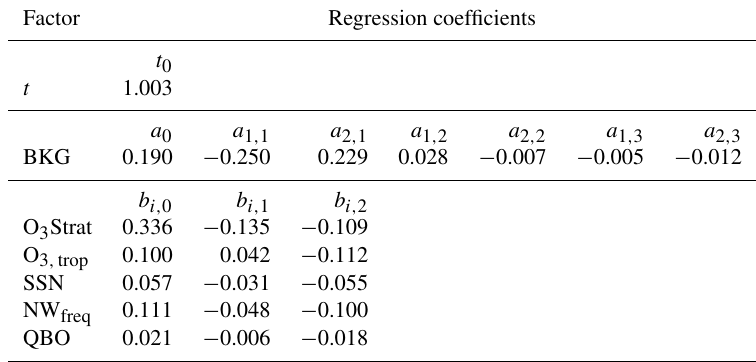
Table 6. Multivariate regression coefficients (Eqs. 6–7) of the surface ozone at WLG. Factor Regression